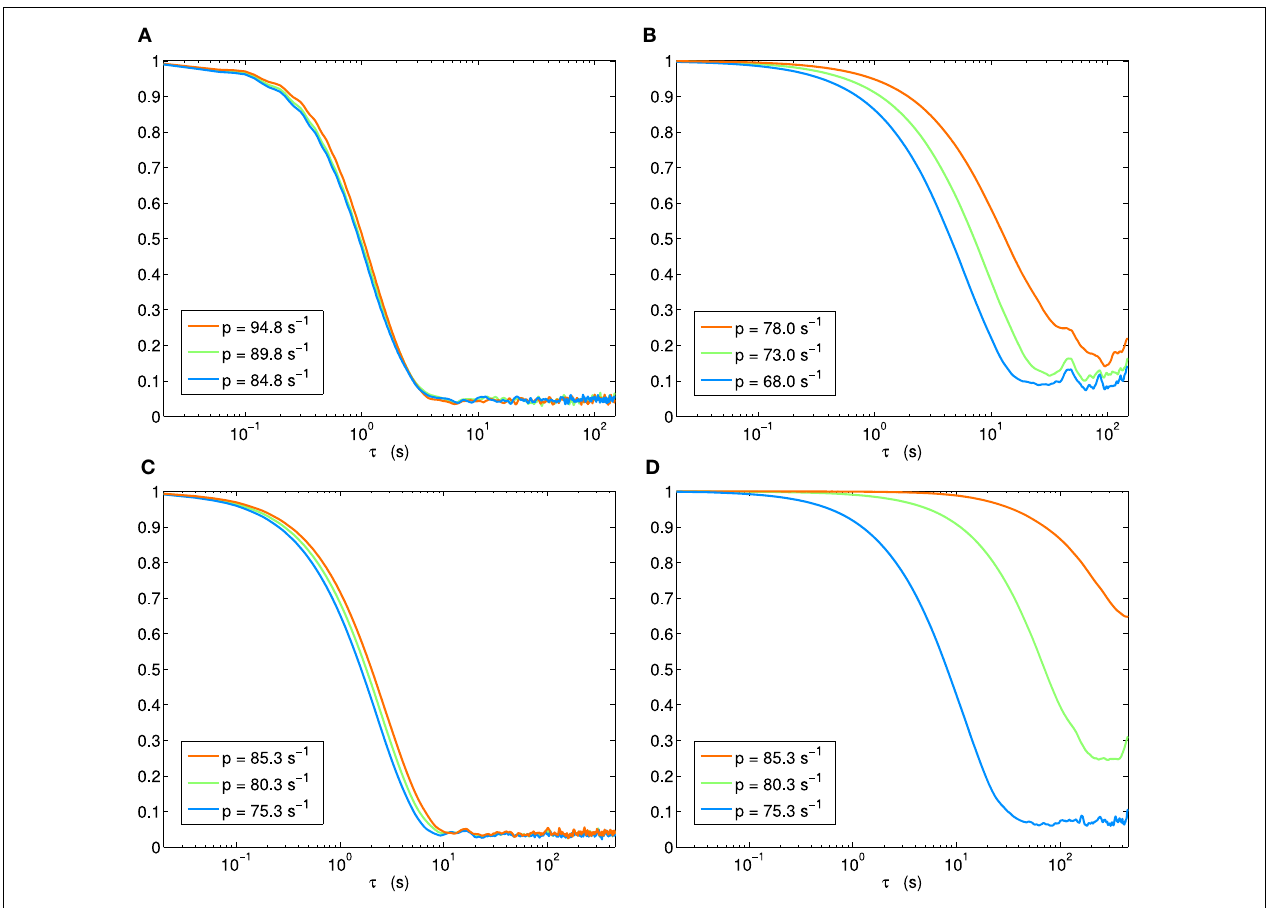
FIGURE 8 |Autocorrelation amplitude in log(delay)-linear(correlation) coordinates. Each panel shows step immediately before (blue), at (green), and beyond (orange) Hopf bifurcation. (A) Scenario H1, (B) H2, (C) H3p, (D)